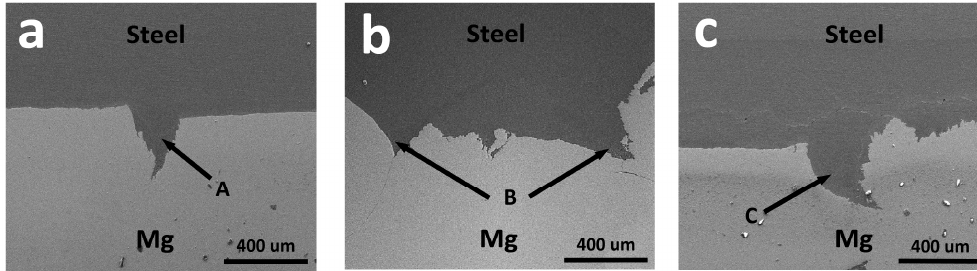
Figure 11. The typical mechanical connection of FSKSW: ( a ) zigzag interface A; ( b ) zigzag interface B; and ( c ) zigzag interface C.